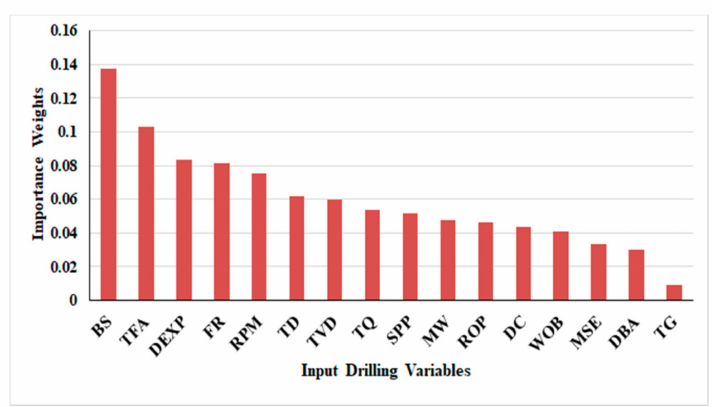
Figure 6. Importance of input drilling variables for the selection of drill bit